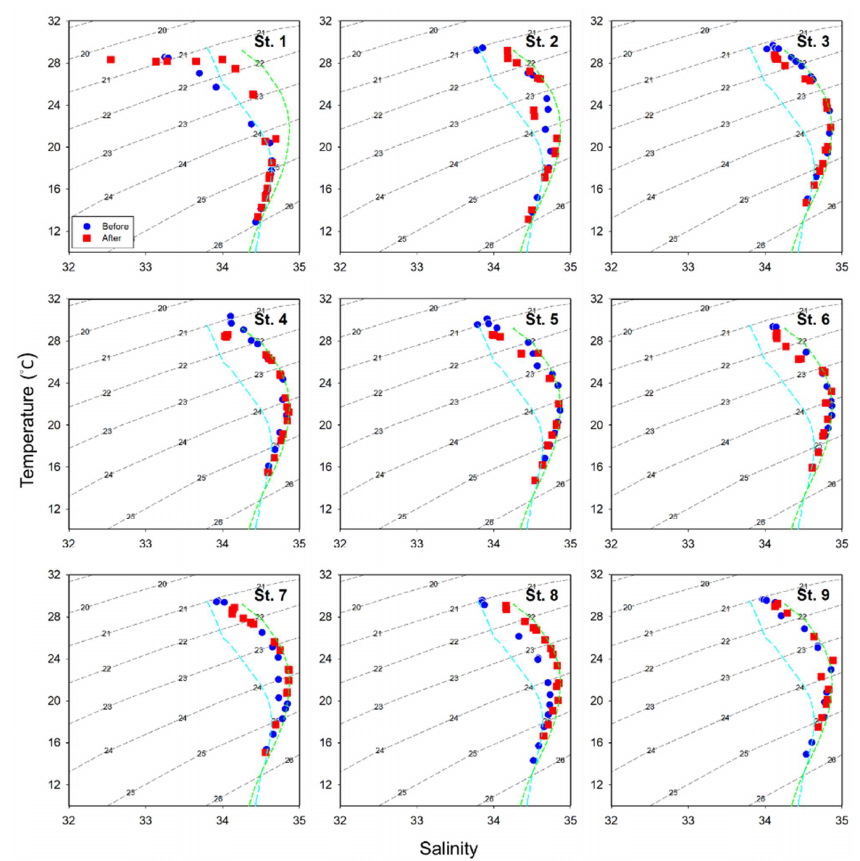
Figure 6. Comparison of T-S diagrams before (blue symbols) and after (red symbols) the typhoon passage at the nine hydrological stations. Cyan and green lines refer to the typical T-S diagrams for the South China Sea water and the Kuroshio water, respectively, according to data from [13,29].